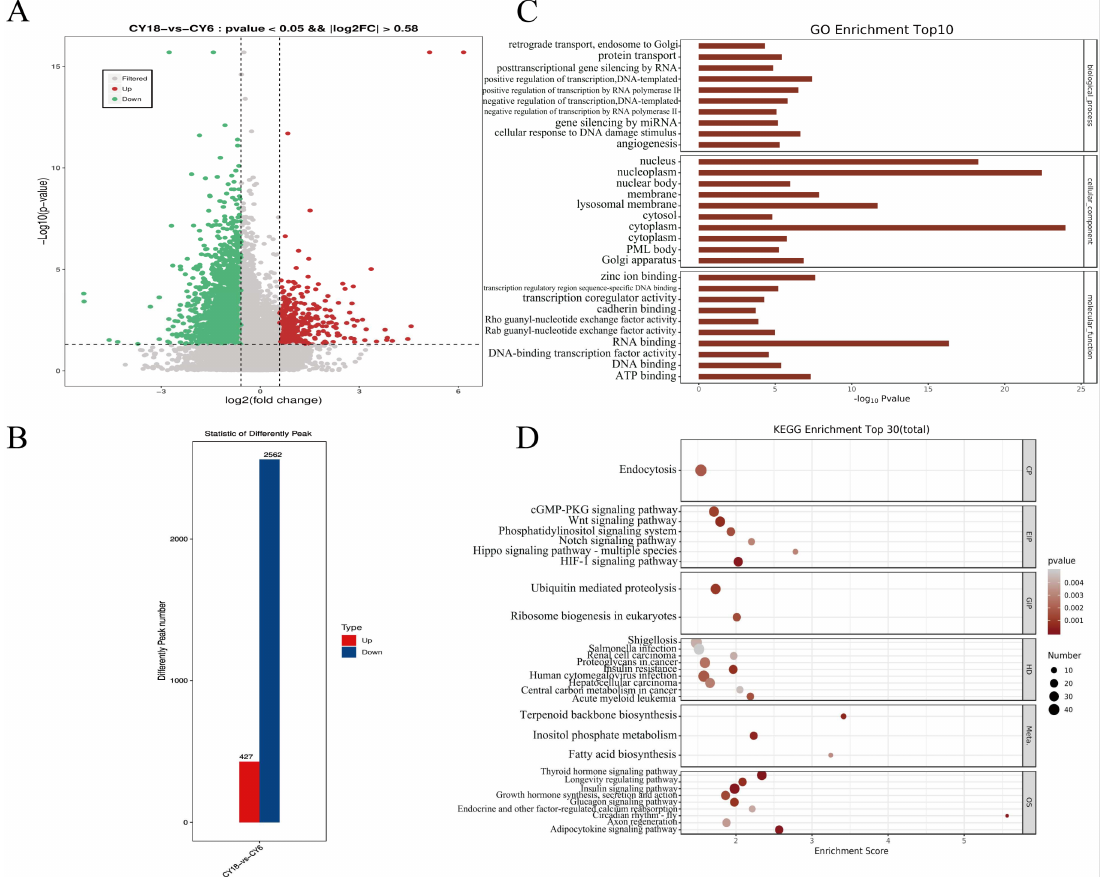
Figure 3. Analysis of the DMPs in cattle-yaks of different development stages: ( A ) volcano plots showing the DMPs between two groups; ( B ) number of up- and down-regulated DMPs; ( C ) GO analysis of DMPs; ( D ) the top 30 significant enriched pathways of